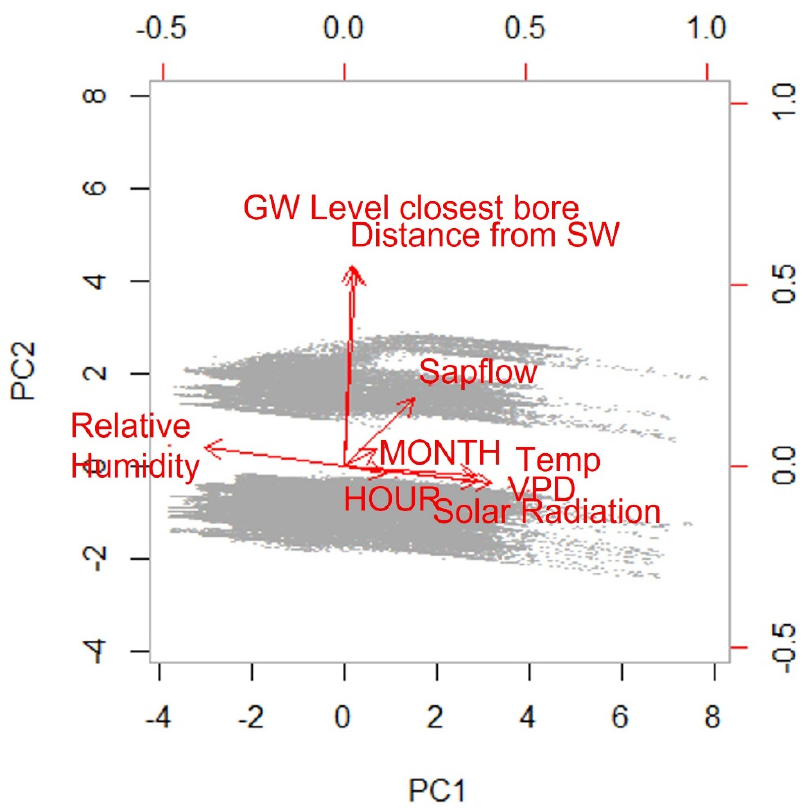
Figure 8. Score plot from the PCA, showing that PC1 was driven by the climatic variables and PC2 was driven by hydrologic variables (distance from the lagoon and depth to groundwater).